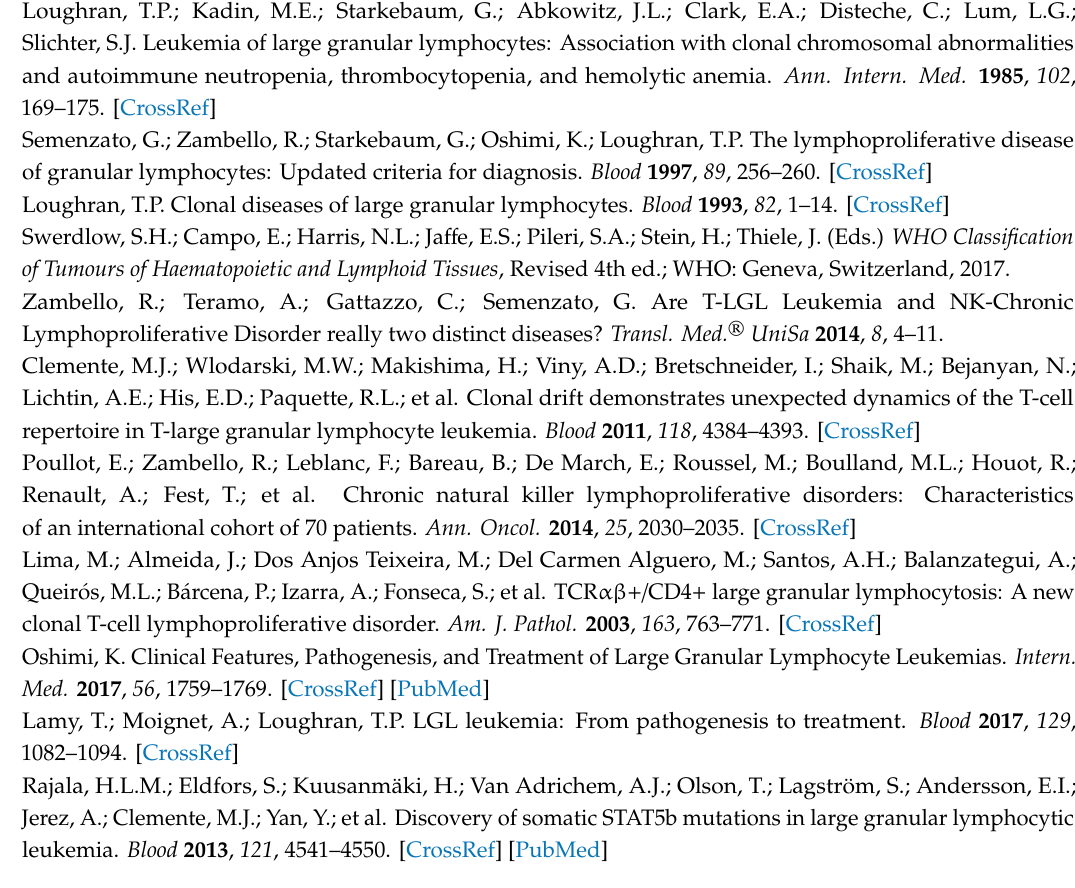
Table S11: STAT3 and STAT5B primers and temperature conditions used for PCR-based gene mutation